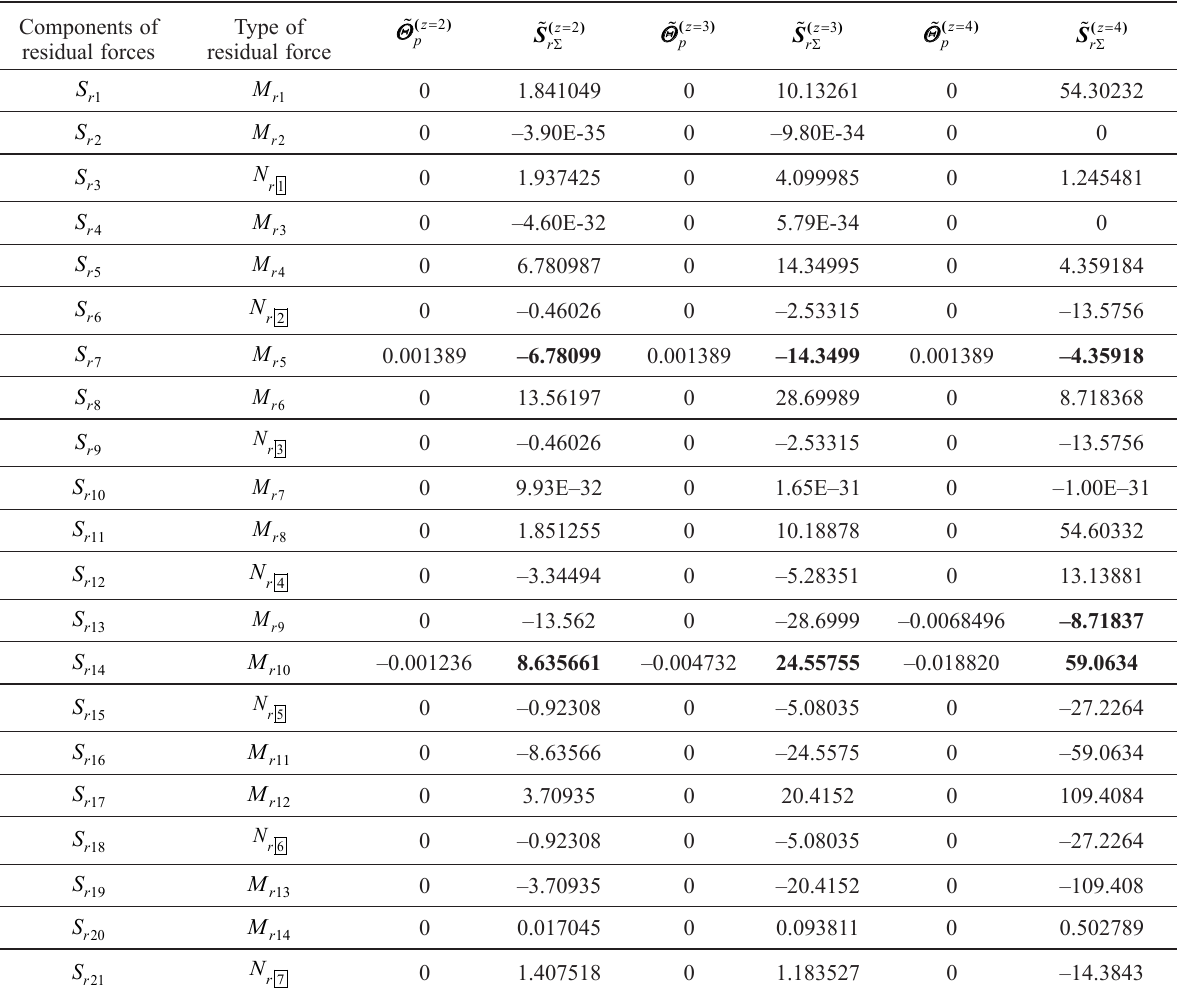
Table 3. Actual plastic